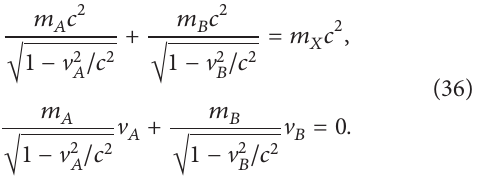
the Borel mass increases. Therefore, we obtain a very narrow Borel window around 𝑀 𝐵 ∼ 0.5